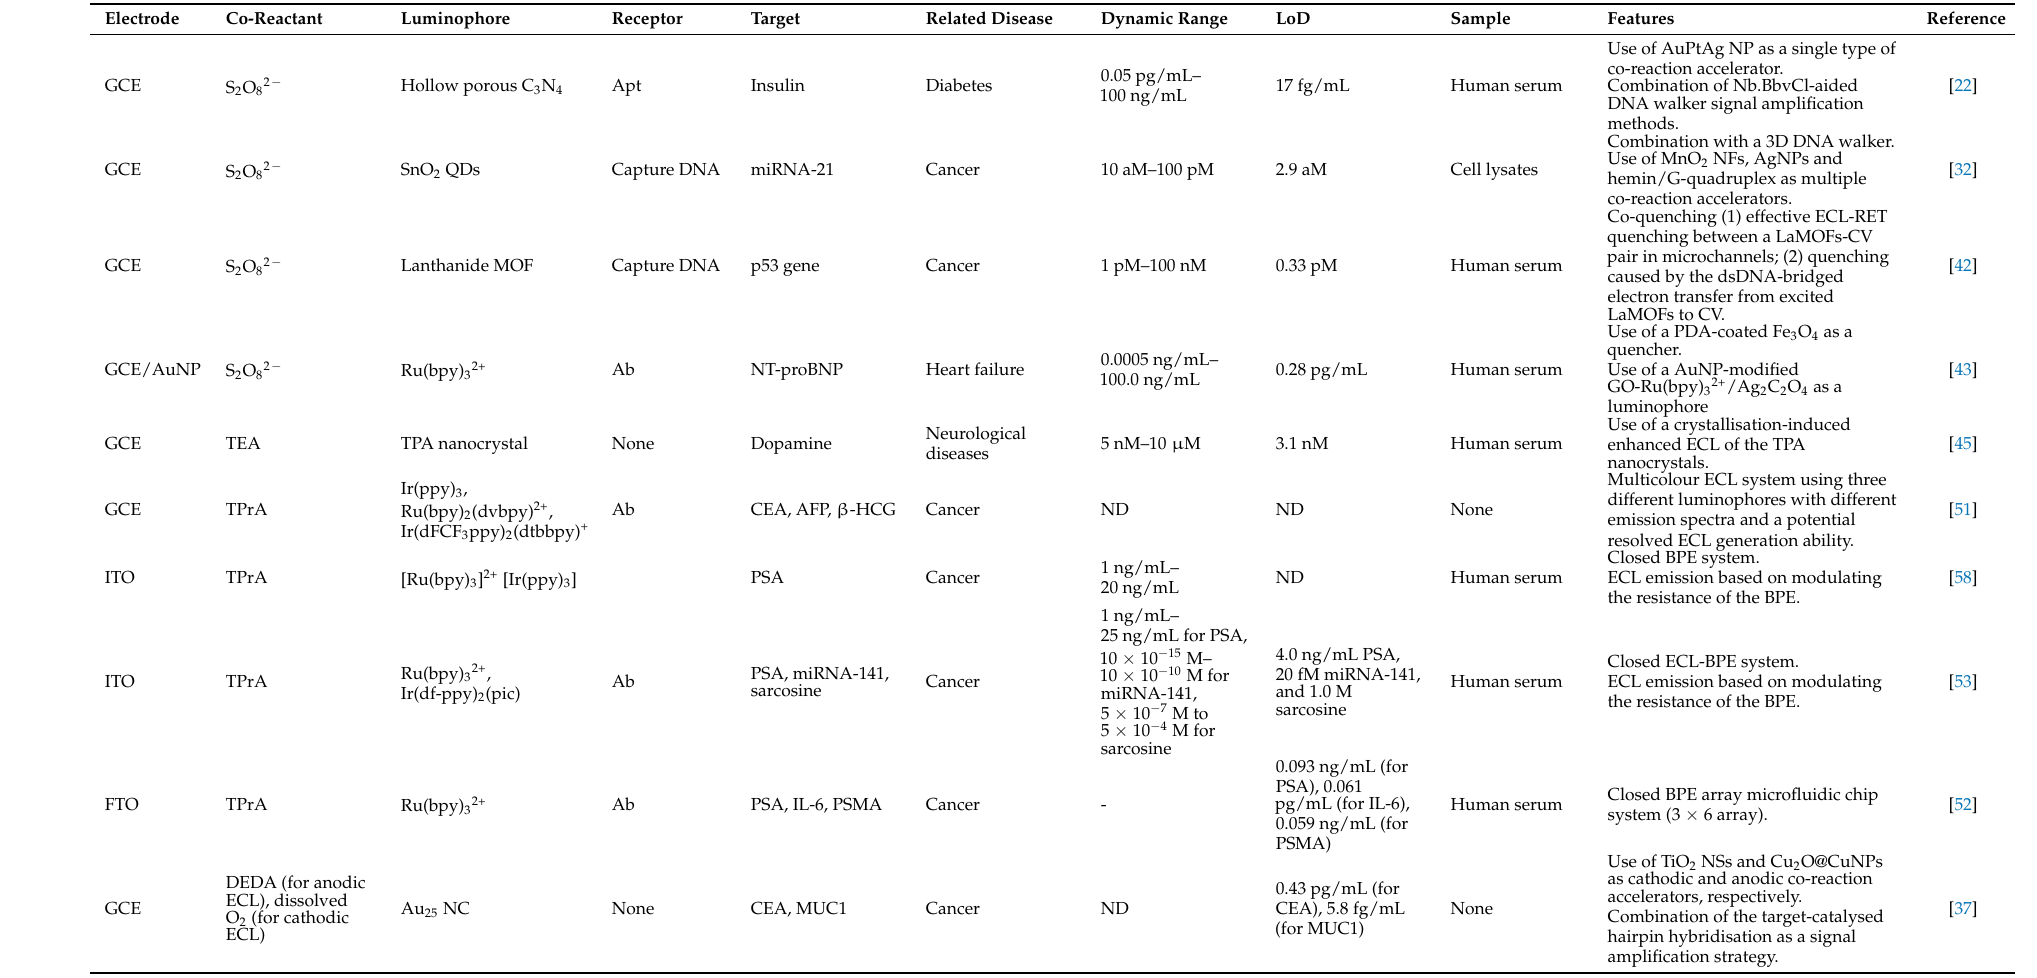
Table 4. Examples of electrochemiluminescence systems for detecting diverse biomarkers